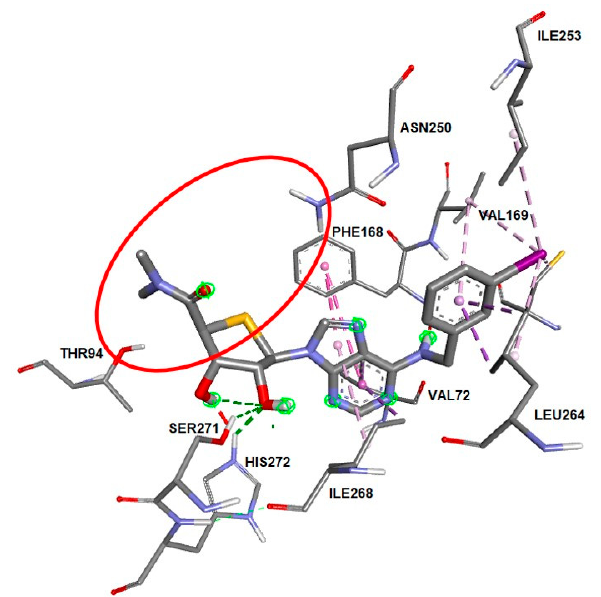
Figure 4. Predicted binding mode of compound 9f in the homology model of hA 3 AR. Hydrogen bonds are depicted as green dashed line. Hydrophobic interactions are marked with a purple dashed line and π - π interactions are marked with a pink dashed line.